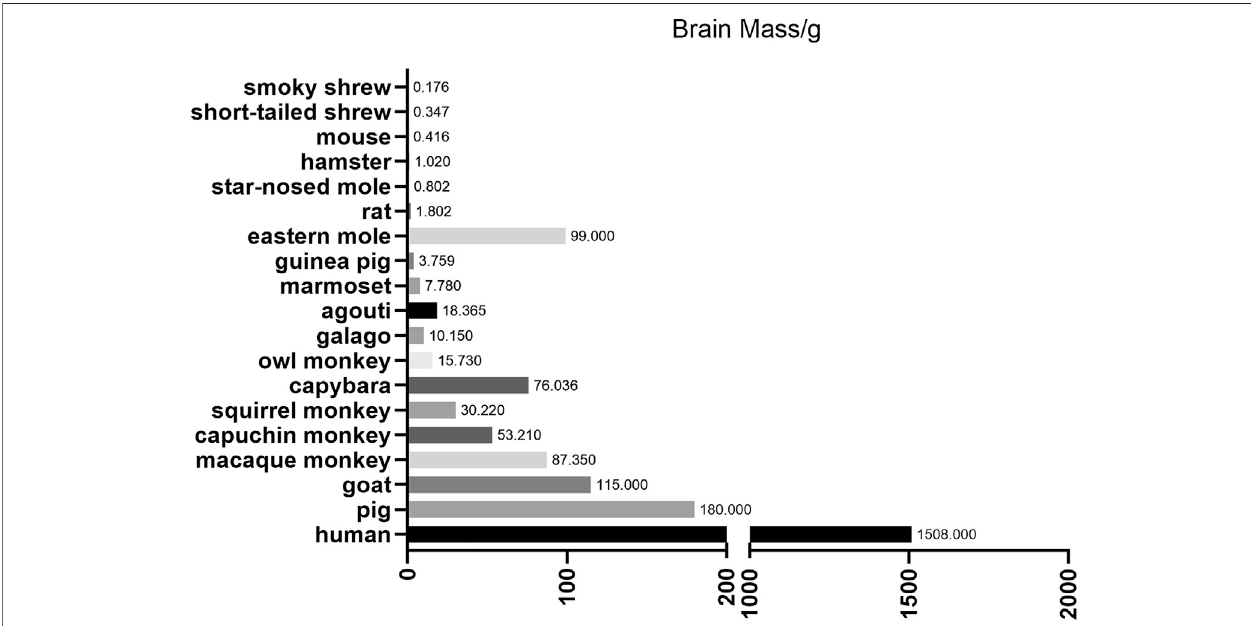
FIGURE1| Brainmassfordifferentanimals.This fi guremainlydepictsthebrainmassofdifferentlargeanimalsandsmallanimals.Noticethatlargeanimals,suchas pigs and nonhuman primates, are much closer to human beings compared with small animals to some extent.